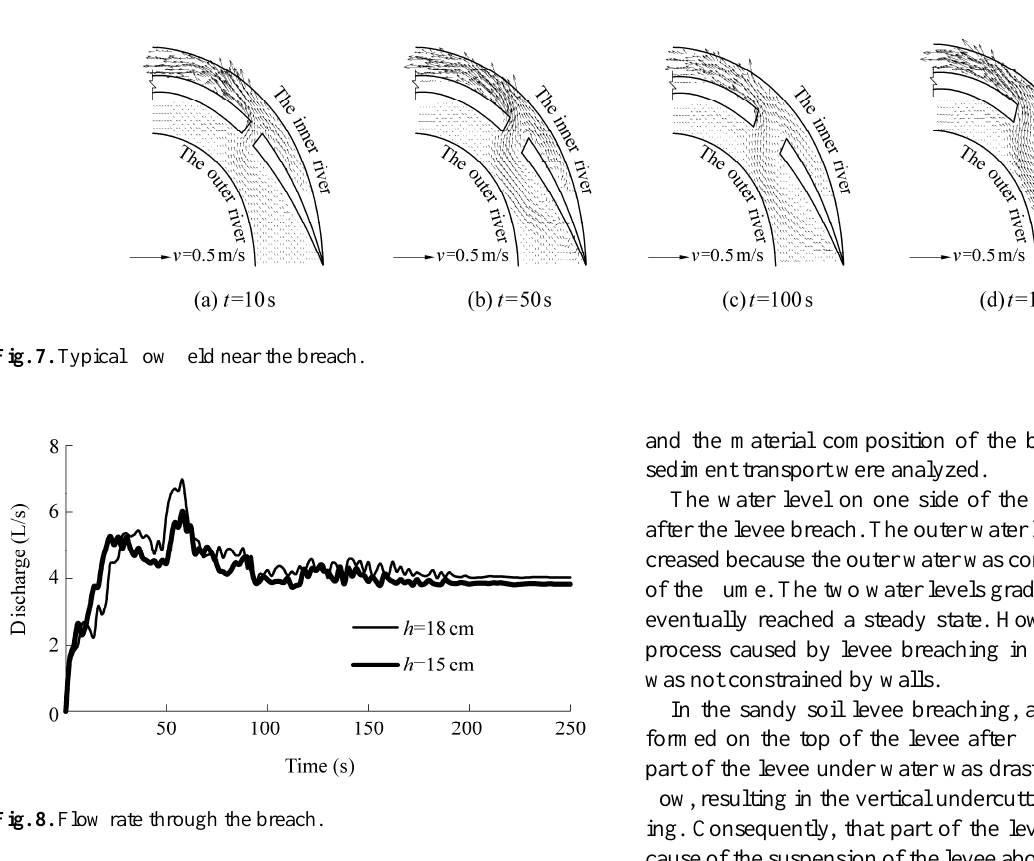
Fig. 8 Flow rate through the breach.